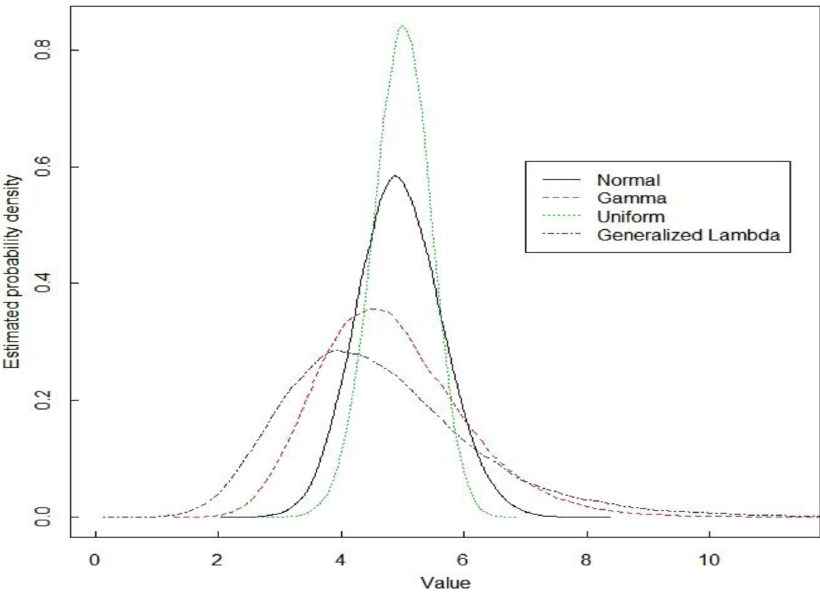
Fig. 6. The estimated probability density for d ^ IR in the four example measurement error probability densities (normal, gamma, uniform, and generalized lambda, each with mean 0 and variance 1) from Figure 4.